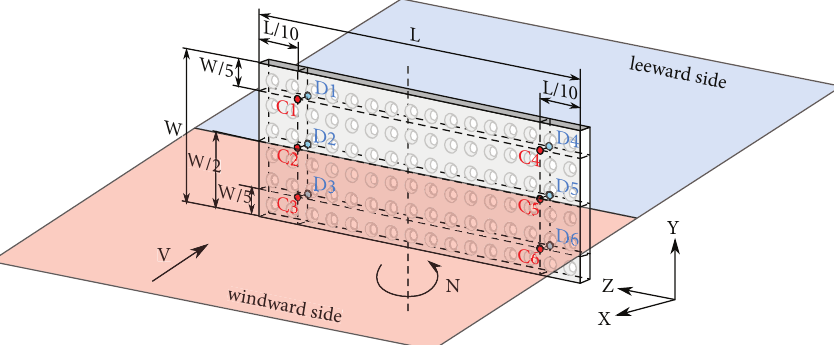
Figure 19: Schematic diagram of pressure monitoring points on the surface of the porous plate antenna. Red region represents the windward side of the antenna, blue region represents the leeward side of the antenna, and rotation is counterclockwise.